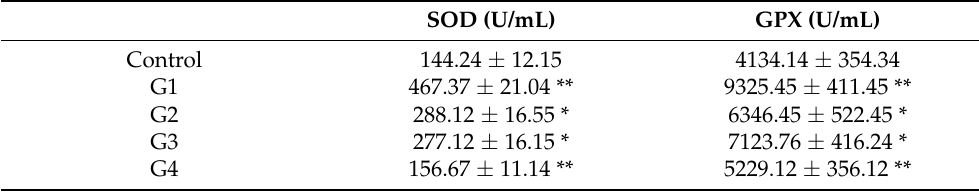
Table 3. Superoxide dismutase (SOD) and glutathione peroxidase (GPX) activity of the rabbits that received the Gallium-68 injection with and without protective antioxidants Angelica archangelica and Ginkgo biloba, as well as with a combined dose as compared with the control group (Mean ± SE). SOD (U/mL) GPX (U/mL) Control